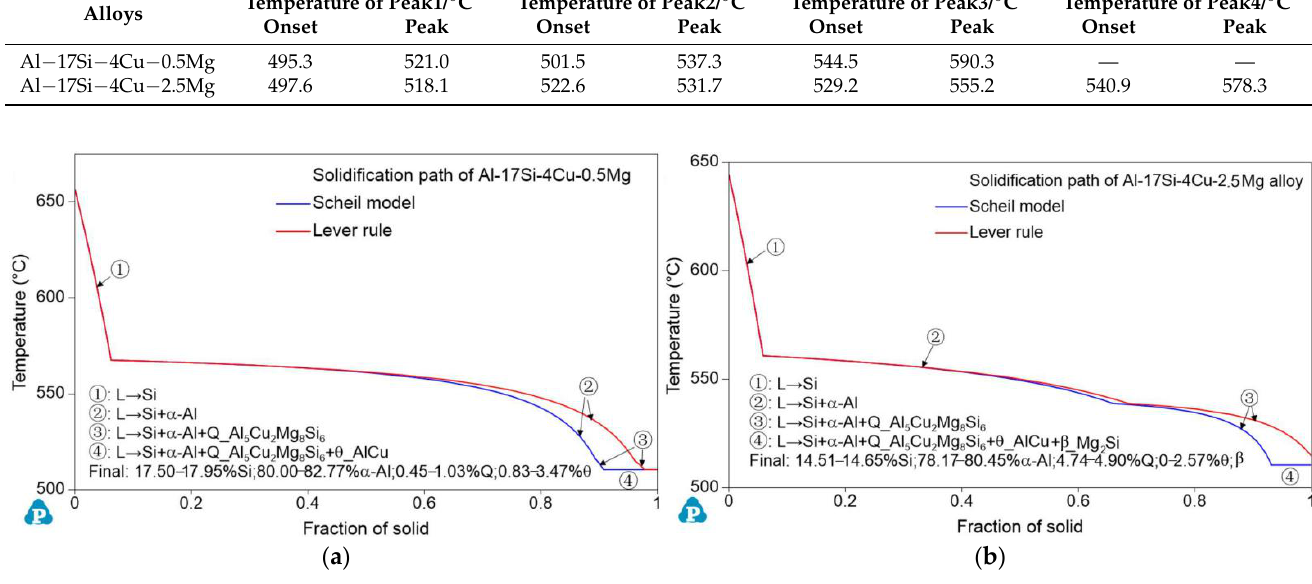
Figure 4. Solidification path of the Al–17Si–4Cu–xMg alloy with temperature in Al–17Si–4Cu alloy solidification containing ( a ) 0.5 Mg and ( b ) 2.5Mg.